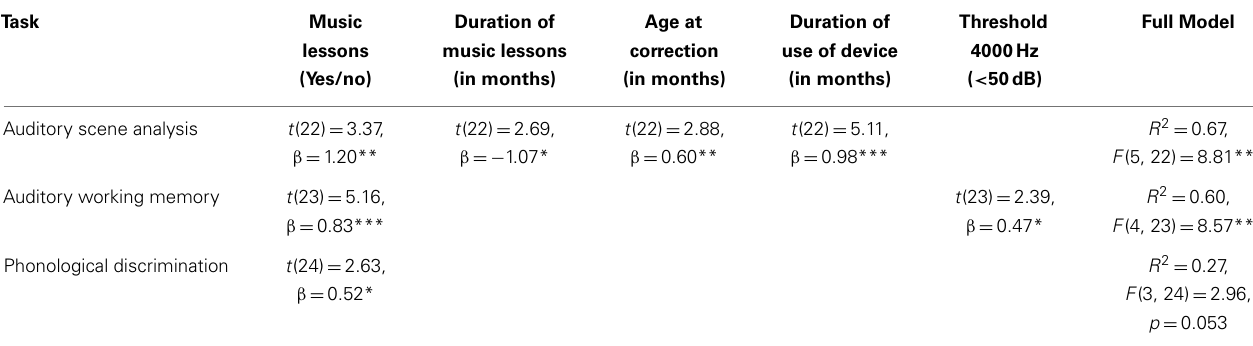
Table 2 | Results from the multiple regressions including R 2 , F , β , and t statistics .